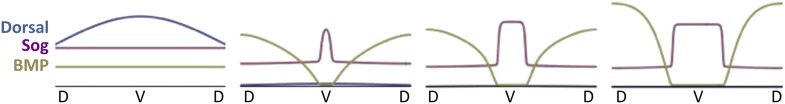
Temporal progression of pattern formation.Simulated concentration profiles of NF-κB/Dorsal, Sog and BMP are plotted at successive time points, starting from a broad peak of NF-κB/Dorsal (left to right: t = 0 hr, 4 hr, 6 hr and steady state; see Table 1 for parameter values). The x-axis shows the circumference of the embryo, with the dorsal and ventral sides marked as D and V, respectively.